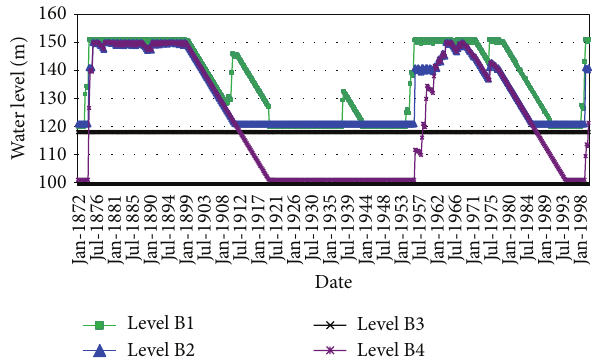
Figure 14: Water level time series for TD configuration C.